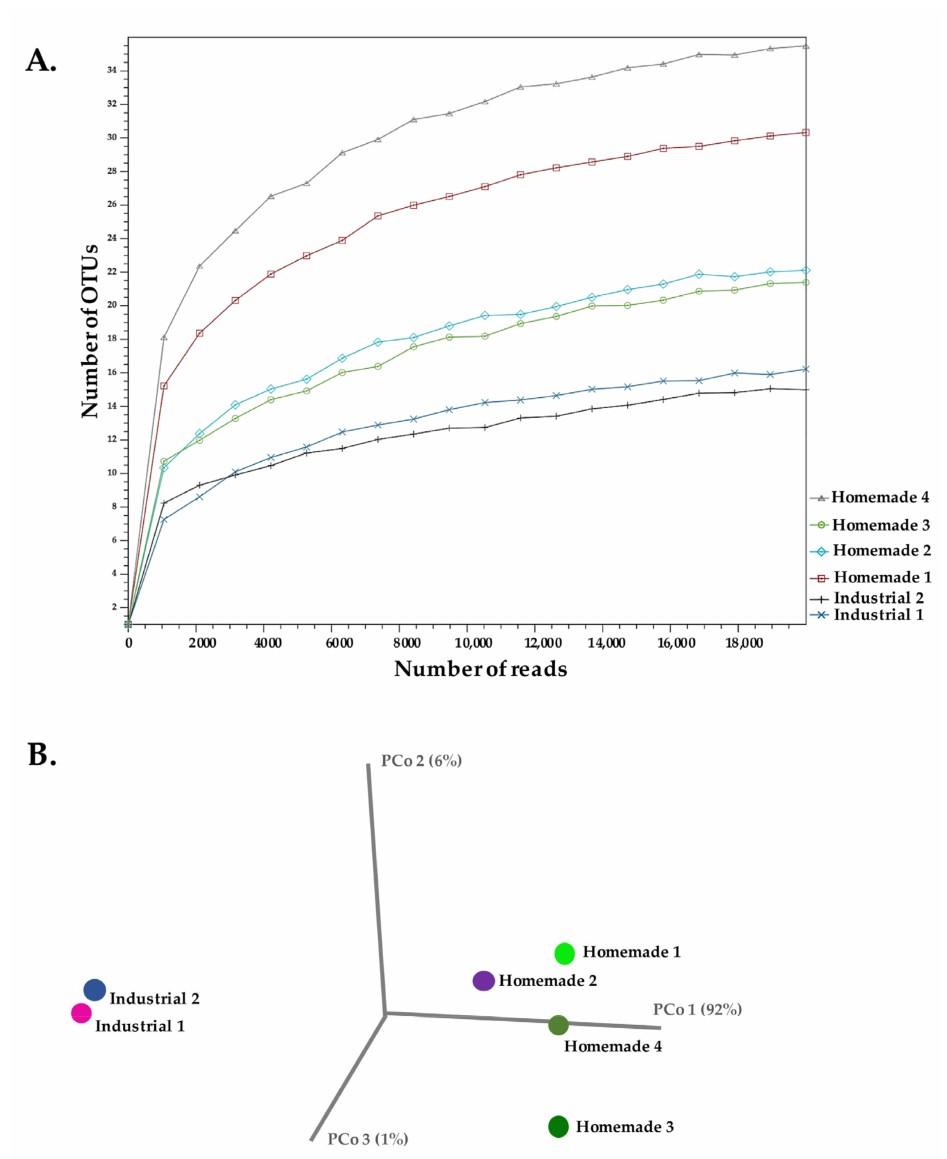
Figure 2. Alpha-diversity analysis of 16S rDNA reads for a maximum depth of 20,000 read counts measured using the total number of OTUs at genus level of industrial and homemade Feta cheese samples ( A ). Beta-diversity presented in a principal coordinate analysis (PCoA) employing the Bray–Curtis distances for the same samples ( B